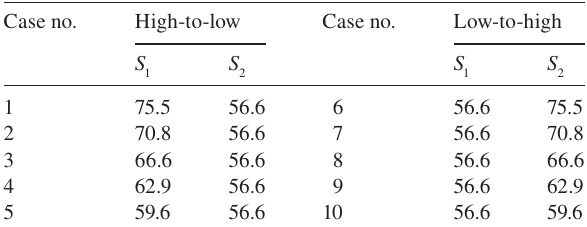
Table 2 Monte Carlo fatigue loading simulation of G1/Ep ( ± 45) laminate.